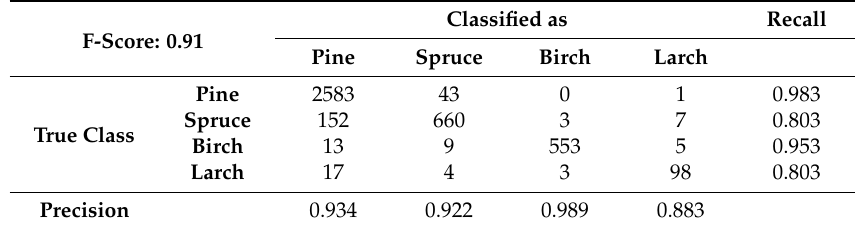
Table 14. Confusion matrix of classification using the k-NN method with the k = 3 with a feature-selected data set. F-score presents the mean F-score for all species.